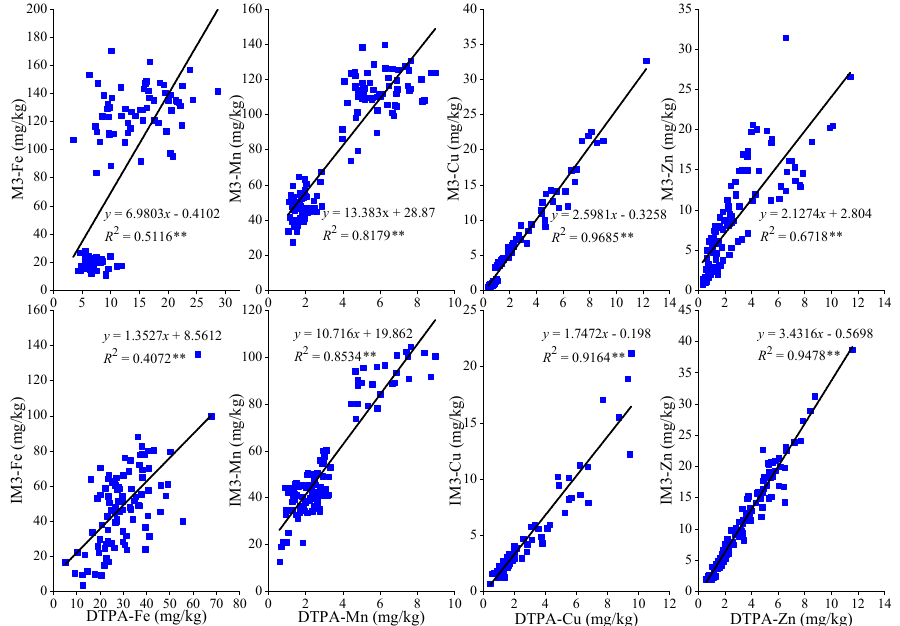
Figure 3. The correlations of the contents of soil available Fe, Mn, Cu and Zn determined by three test methods (** p < 0.01).